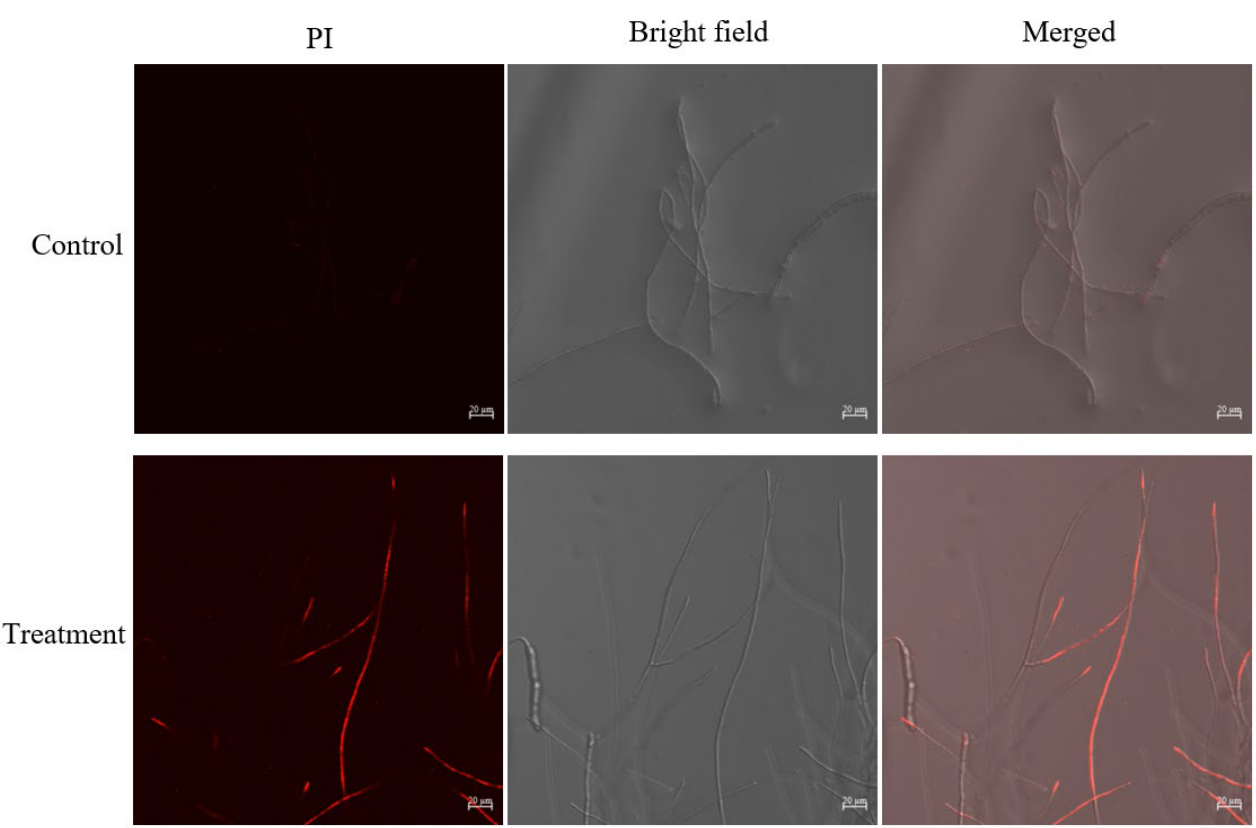
Figure 5. Microscopy analyses of B. sorokiniana hyphae treated with JK-25 crude extract. Both control and treated groups were incubated at 30 °C for 12 h and then observed after PI staining.